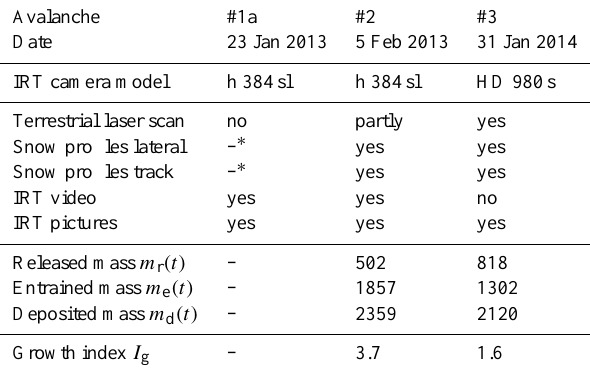
Table 1. Summary of measurements for the investigated avalanches.